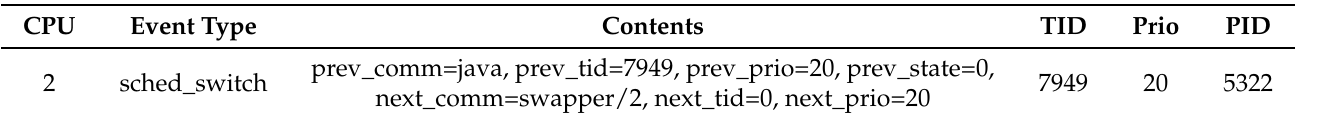
Figure 17. Use case: preemption without replacement. The Resources view in Trace Compass shows that the java thread used by Cassandra is preempted but not replaced. Table 5. Use case: scheduling event for a worker thread. The worker thread is replaced by the virtual process swapper , which indicates that the CPU is becoming idle. The state of the worker thread is left to 0, meaning it could potentially be